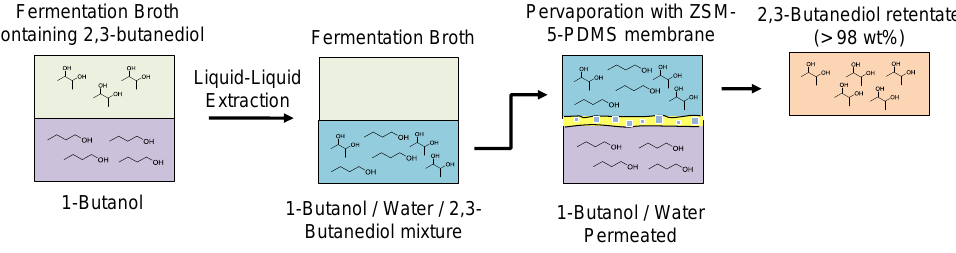
Figure 22. Schematic of the recovery process for 2,3-butanediol studied in [172].